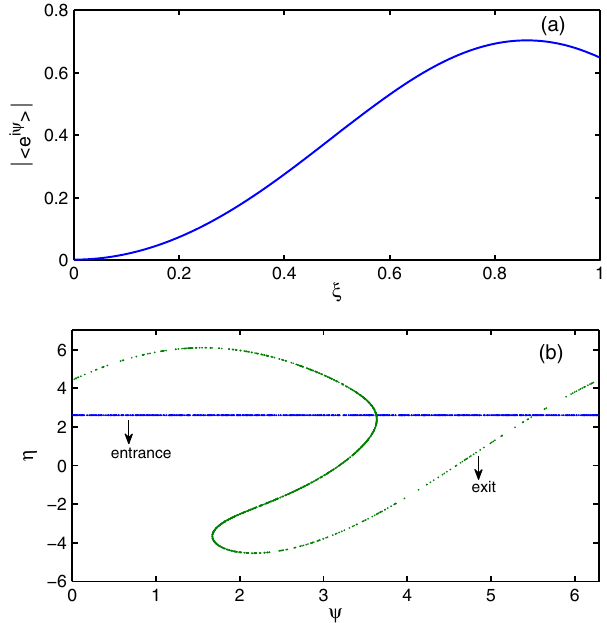
FIG. 7. (a) Plot of growth of the bunching parameter along the interaction length at saturation of the power in the surface mode. (b) The phase space of electron beam at the entrance and at the exit of interaction region at saturation.